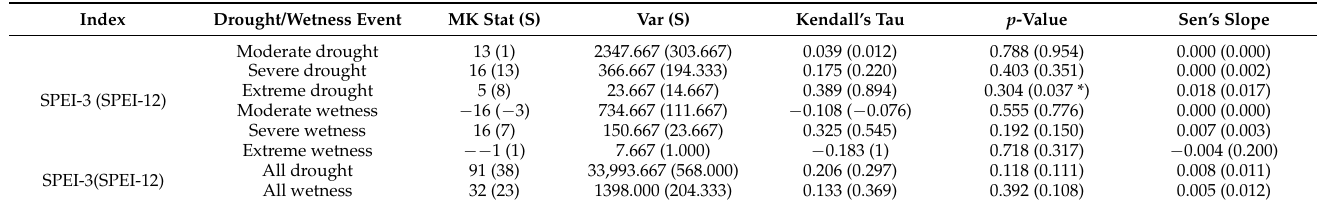
Table 3. Mann–Kendall trend test and Sen’s slope estimate for annual drought and wetness events from